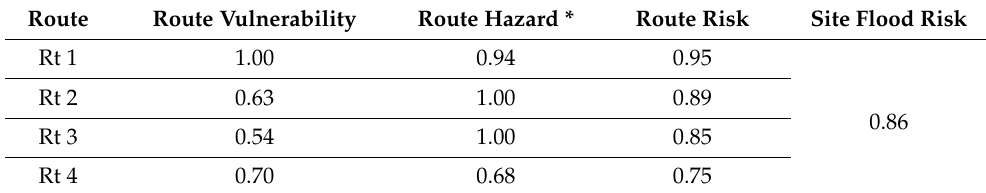
Table 10. Flood risk assessment of Mobility System of industrial park site. Route Route Vulnerability Route Hazard * Route